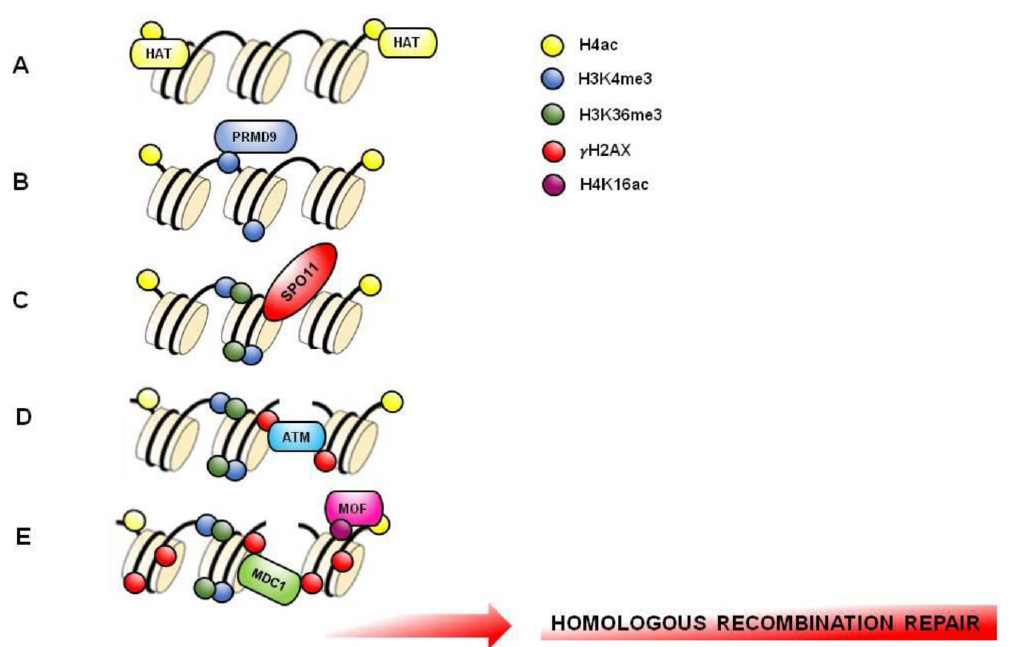
Figure 4. Hypothetical molecular mechanism involved in meiotic hotspots formation. DNA and several nucleosomes are represented. ( A ) Histone H4 acetylation (H4K5ac, H4K8ac, H4K12ac, H4K16ac) (yellow circle) is enriched in PL-SPC to favor an opened chromatin structure that facilitate recombination hotspots formation. ( B ) PRDM9 binds DNA and catalyzes H3K4me3 formation (blue circle) on hotspots. ( C ) H3K36me3 (green circle) associates with H3K4me3 on the same nucleosome to create a hotspot-specific signature recognized by endonuclease SPO11. ( D ) DNA double strand breaks (DSBs) formed by SPO11 triggers the phosphorylation of histone H2AX ( γ H2AX; red circle) by ATM kinase. ( E ) MOF acetylase induces H4K16ac (purple circle) facilitating MDC1 recruitment. MDC1 binds γ H2AX and amplifies its phosphorylation to induce the recruitment of DNA repair factors